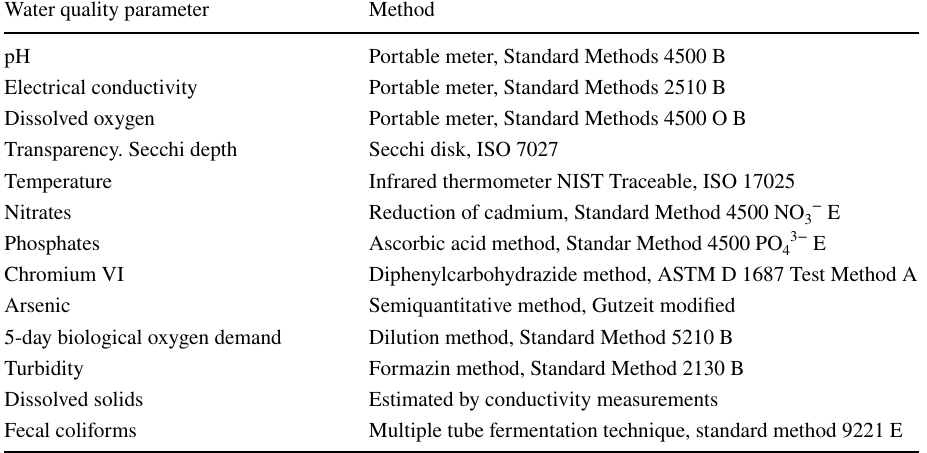
Table 1 Parameters